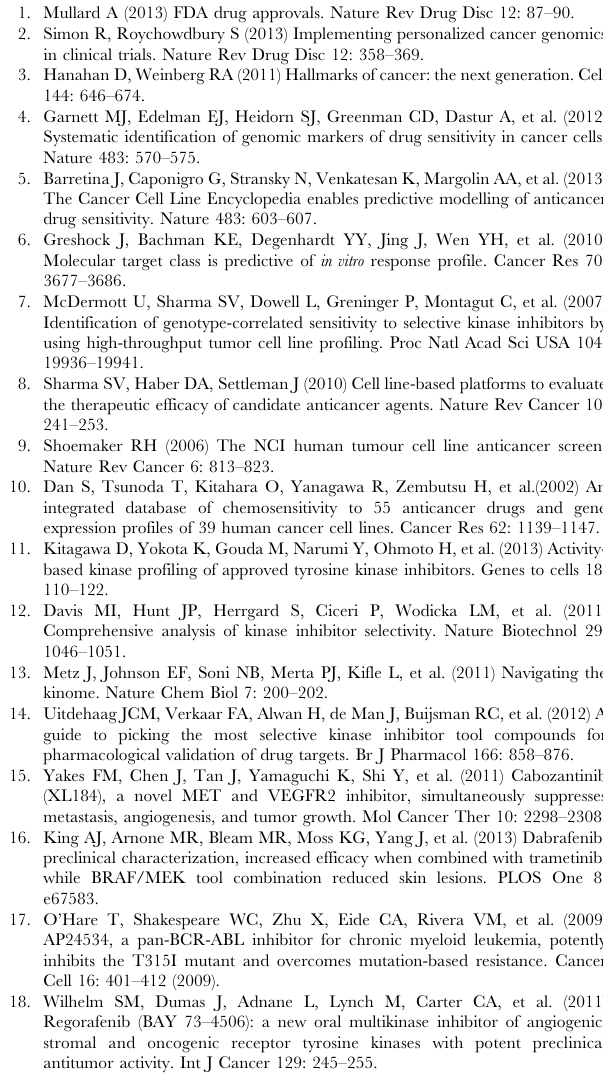
Table S6 Biochemical inhibition of more than 300 kinases by 25 kinase inhibitors (%-inhibition values at 1 m M concentration). Table S7 List of all cell lines in the Oncolines